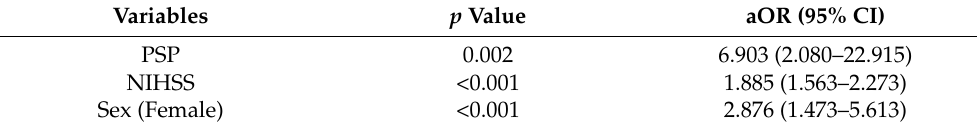
Table 3. Multivariable predictors of